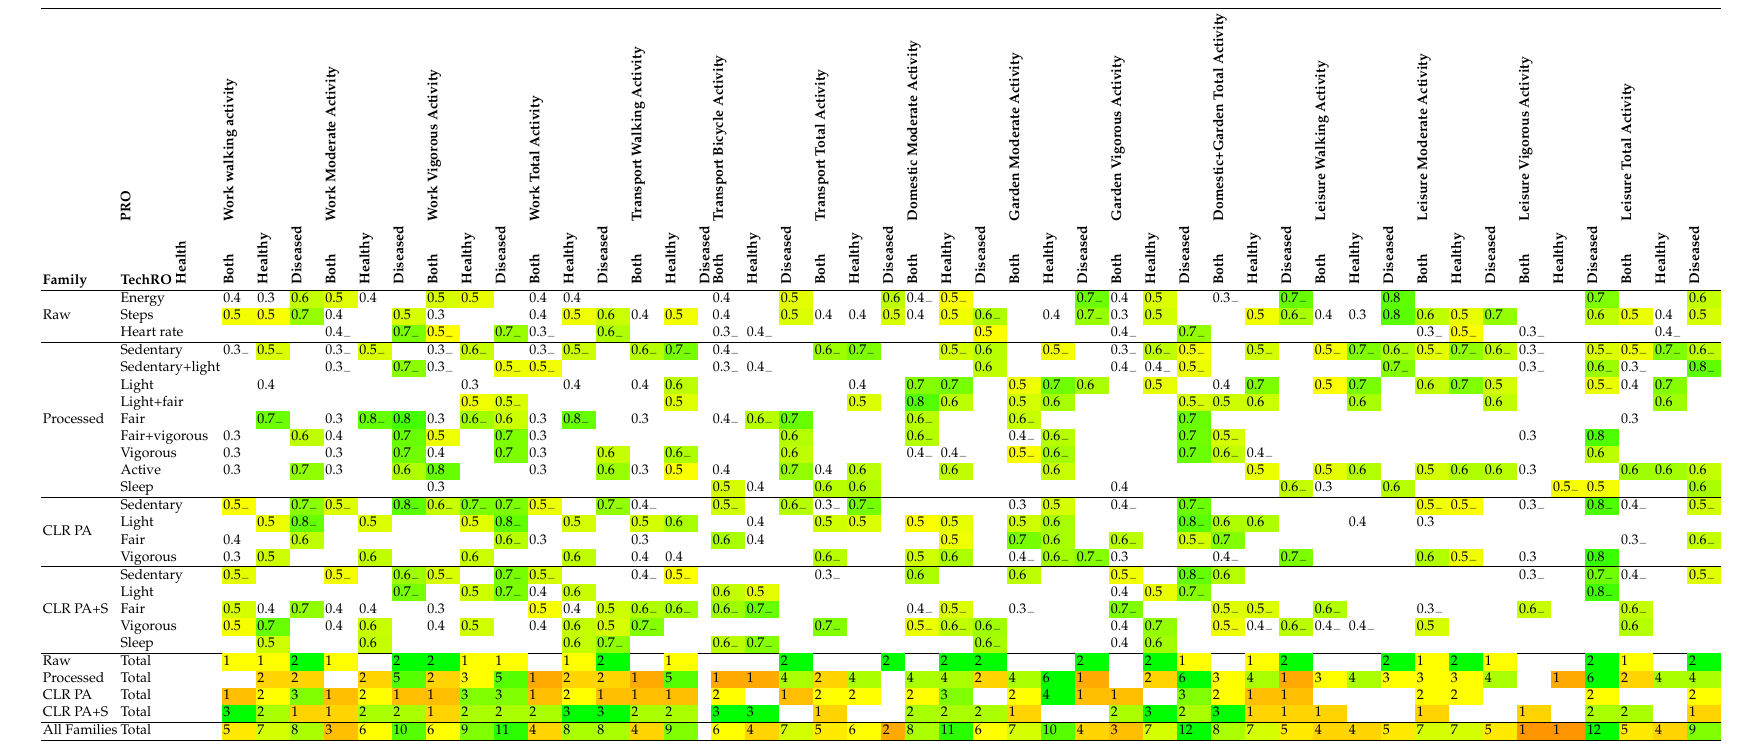
Table A13. Correlation coefficient (Spearman r S ) between TechROs from Fitbit (rows) and PROs of Physical Activity on the IPAQ scale